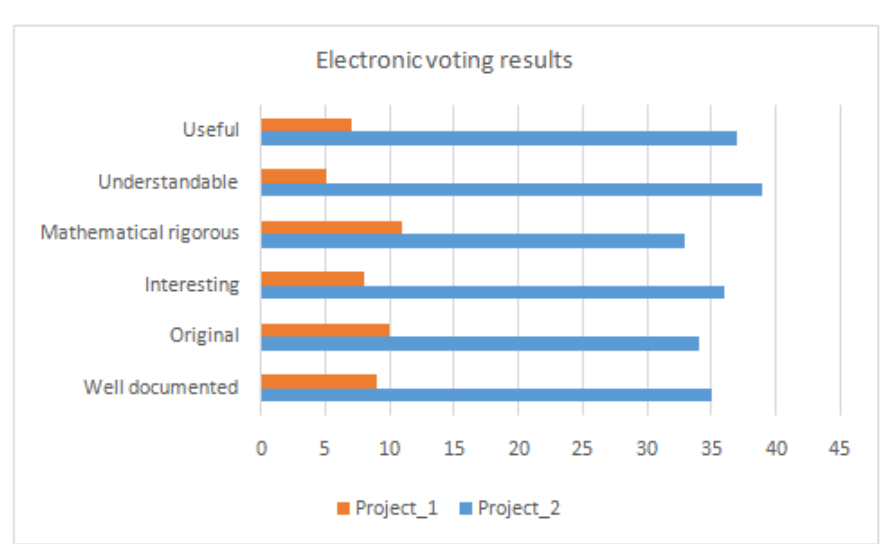
Figure 4. Electronic voting, completed by the APLICA_MATES